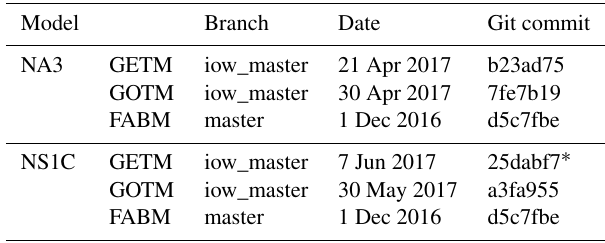
Table 1. Source code revisions used in the present work.